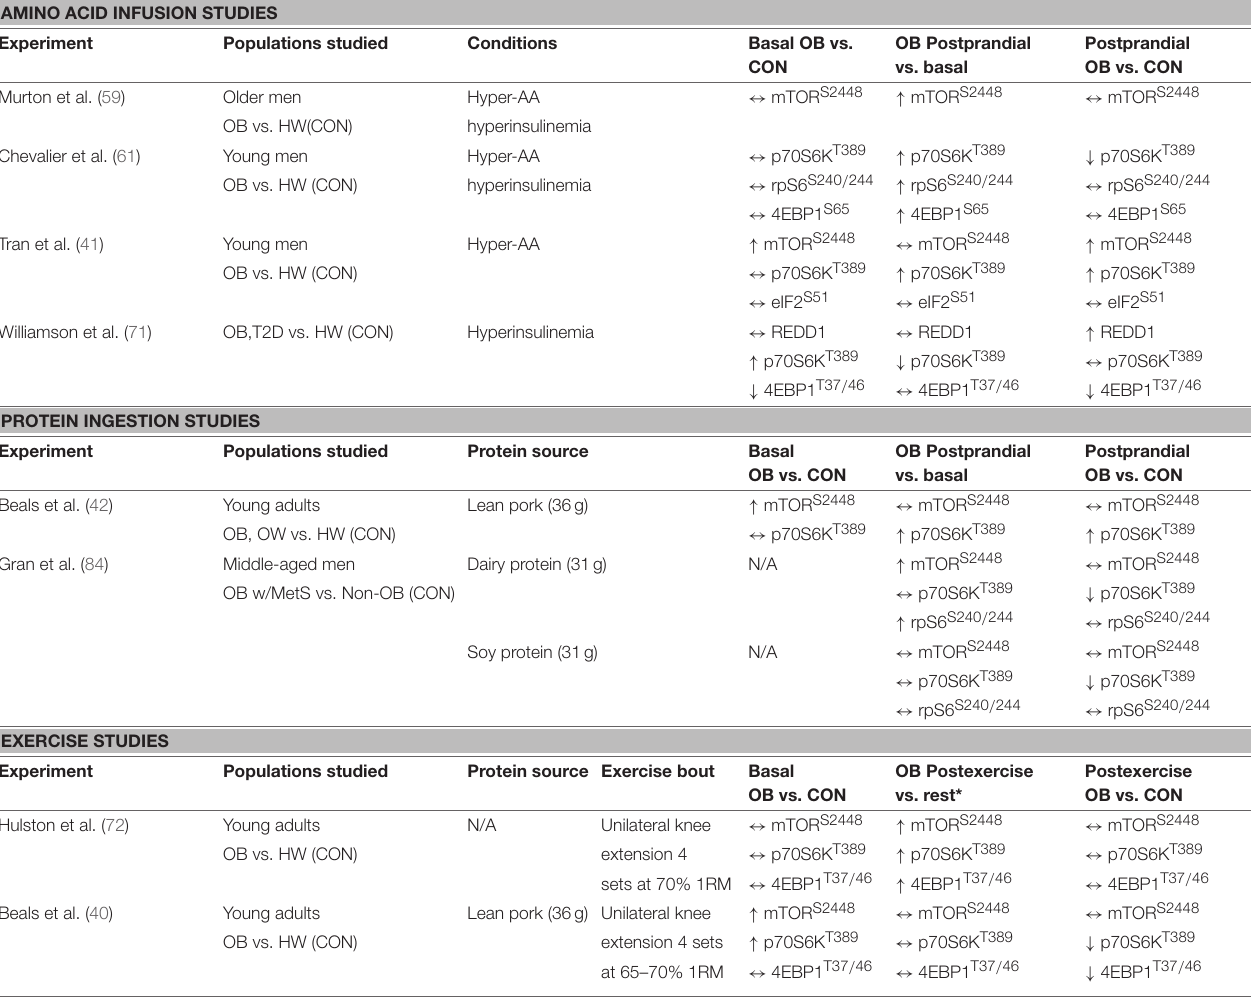
TABLE 2 | Effect of obesity on muscle anabolic